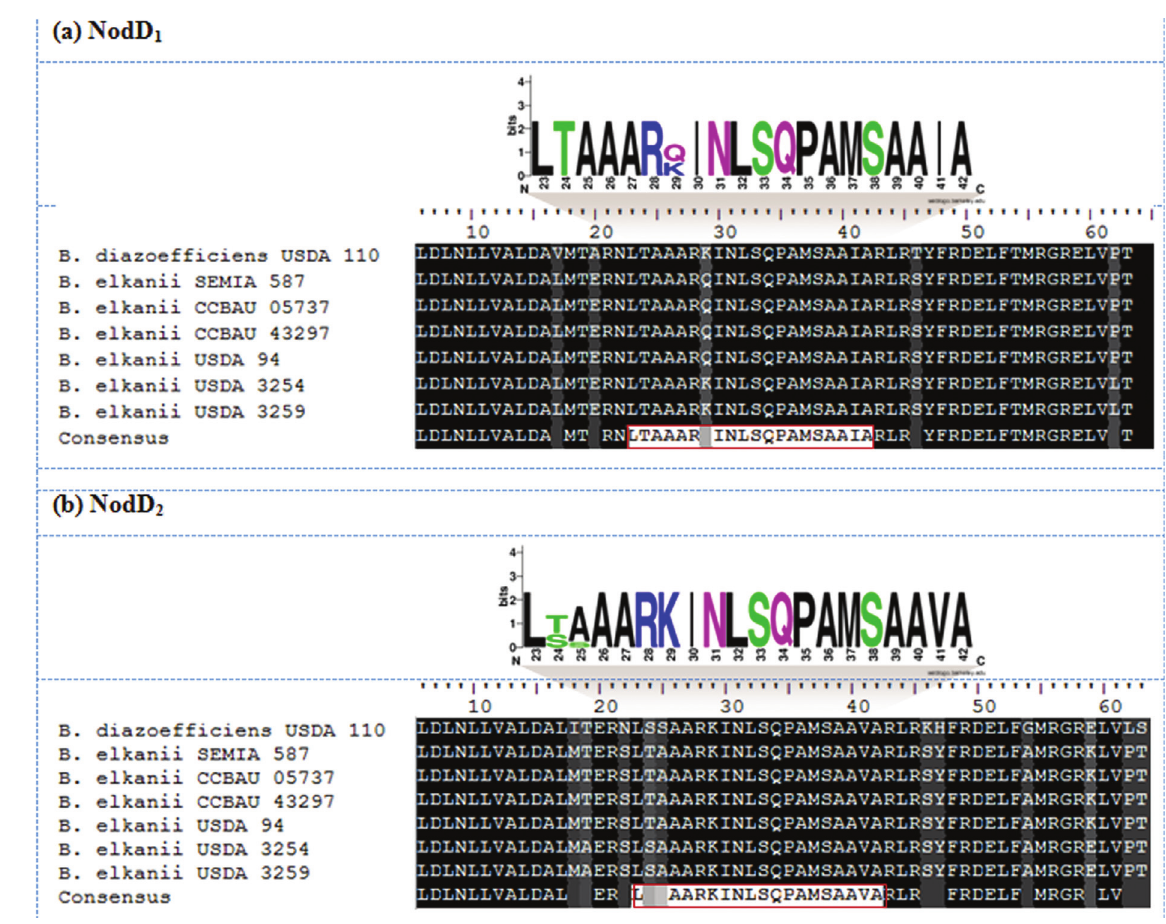
Figure 3 - Multiple sequence alignment (MSA) of the B. elkanii NodD HTH LysR-type domain and sequence logo showing conservation of the HTH DNA-binding motif. The HTH DNA-binding sequence conserved among organisms is boxed in red. The sequences are for the (a) NodD 1 and (b) NodD 2